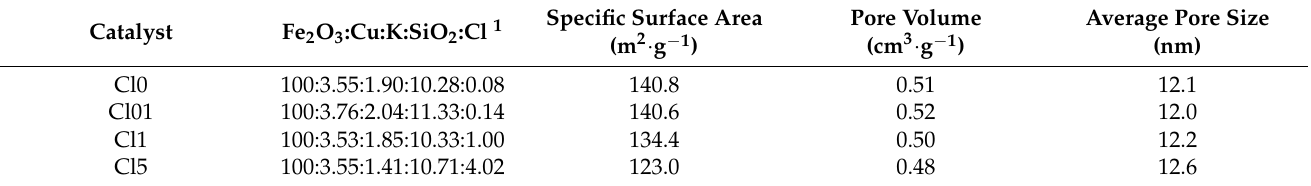
Table 1. Composition, specific surface area, pore volume, and average pore size of freshly prepared precipitated iron